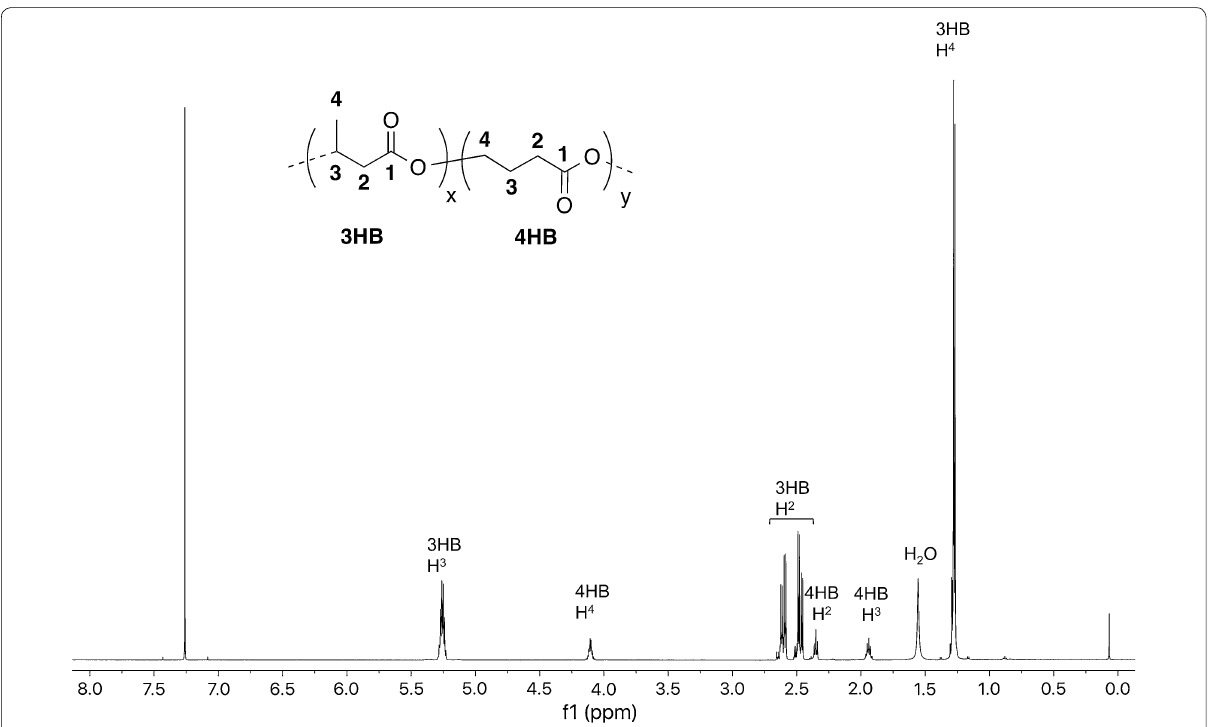
Fig. 1 1 H-NMR spectrum of P(3HB- co -4HB) produced by M. parvus